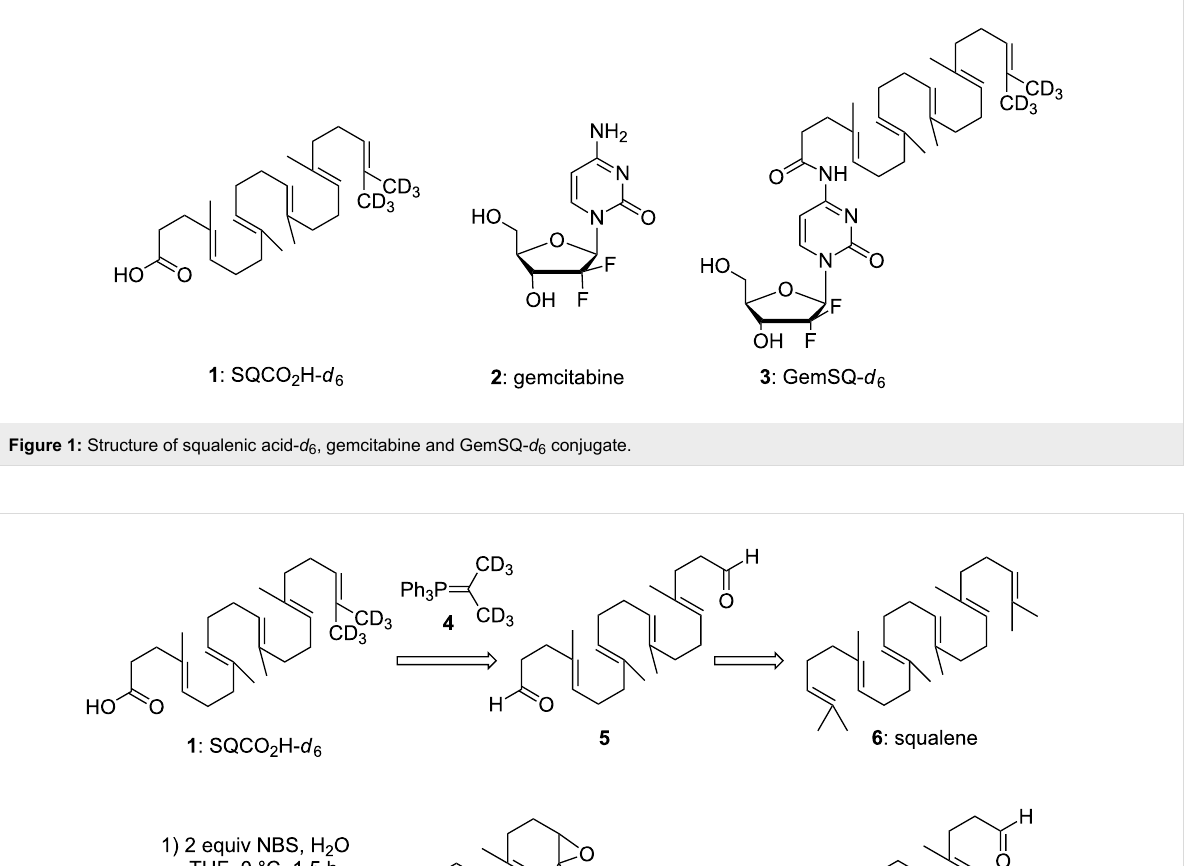
After separation of the bis-bromohydrin from the